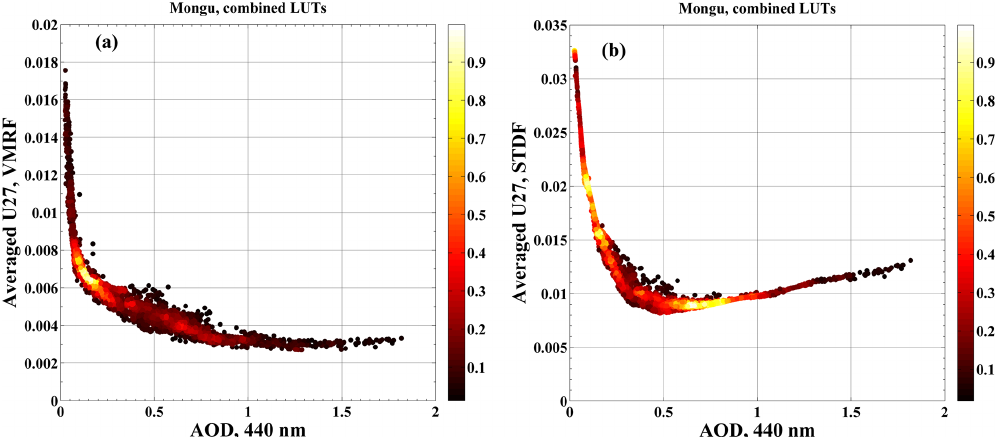
Figure 27. Uncertainties for (a) volume median radius of fine mode and (b) width of size distribution for fine mode estimated at the Mongu